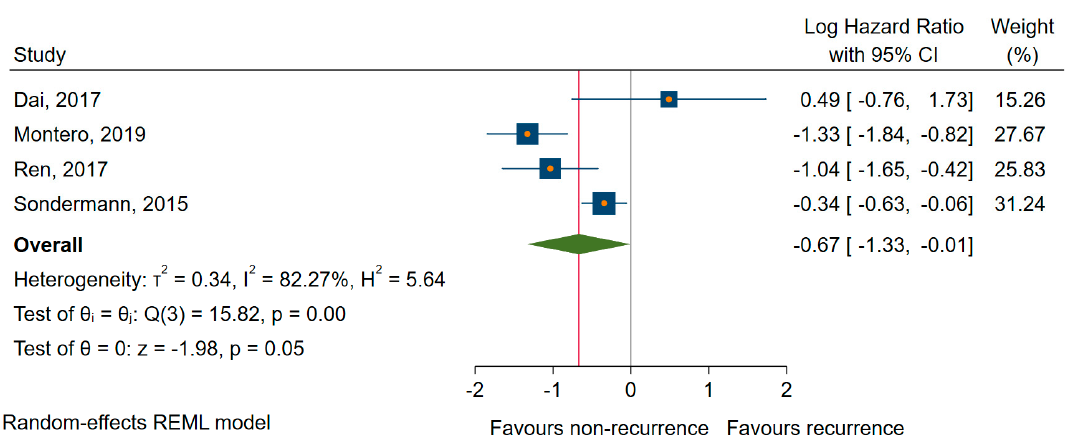
Figure 8. Forest plot of the association between the downregulated miRNAs and DFS/RFS.